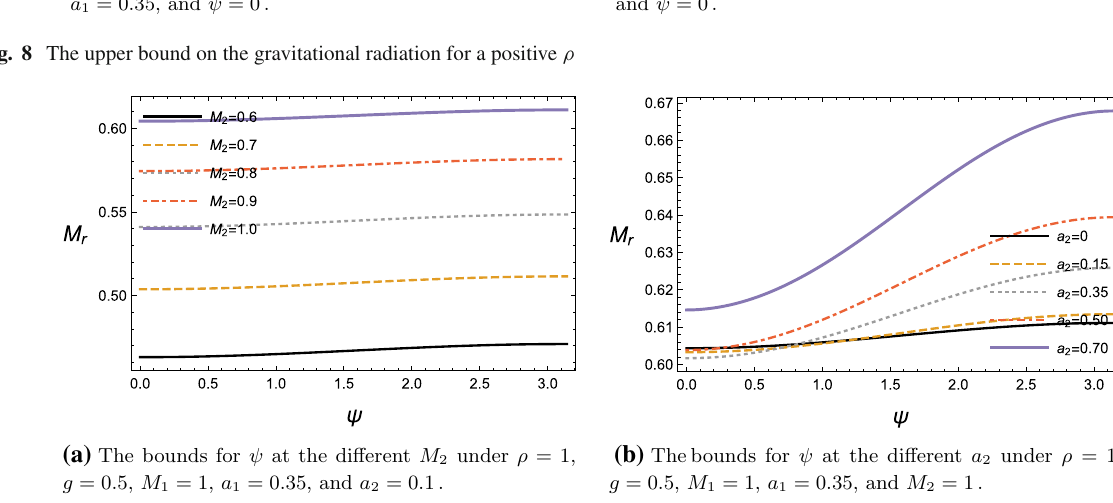
(b) The bounds for a 2 at ρ = 1, g = 0 . 5, M 1 = 1, M 2 = 1, and ψ = 0.